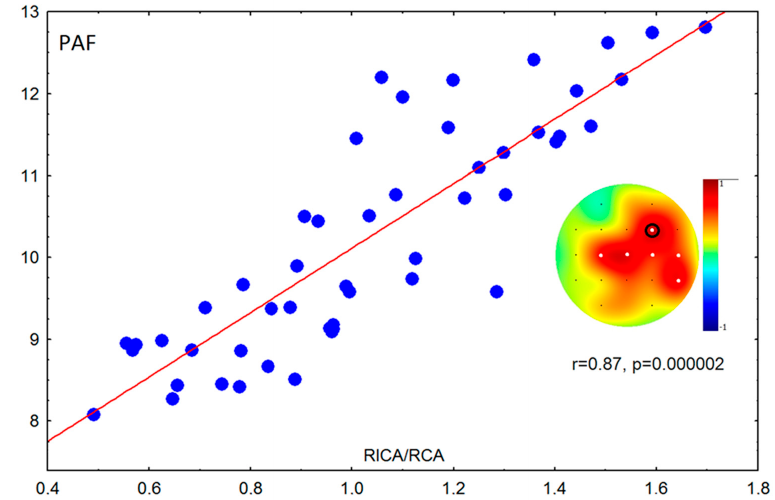
Figure 3. Scatterplot of peak alpha frequency (PAF) against ratio between the systolic peak velocities of the right internal and common carotid arteries (RICA/RCCA) in adults. White dots—significant correlations after Bonferroni correction and the permutation test; black circle—electrode used for scatterplot.